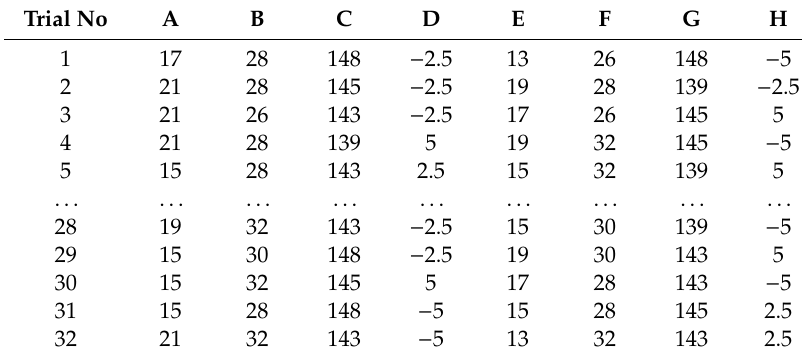
Table 4. Orthogonal